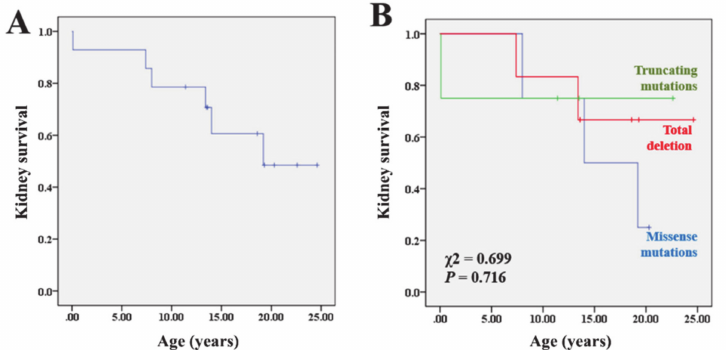
Figure 1. Kaplan-Meier cumulative kidney survival rates in all patients ( A ) and according to the genotype ( B